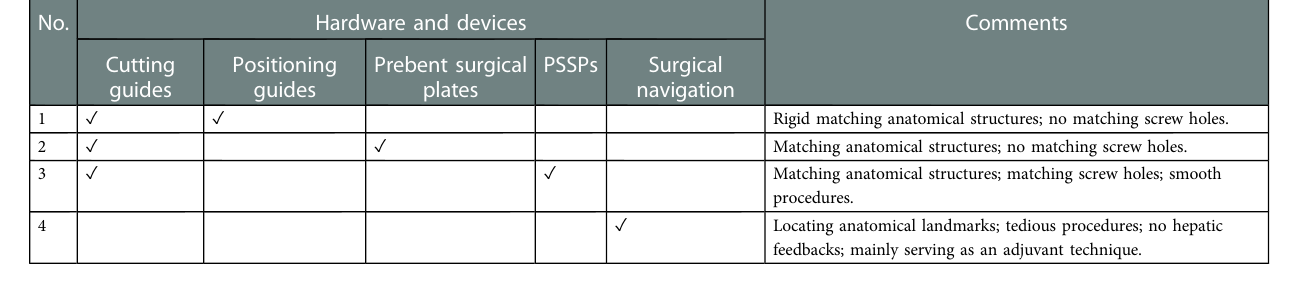
TABLE 2 Major surgical techniques and devices of CAMR in literature. No.